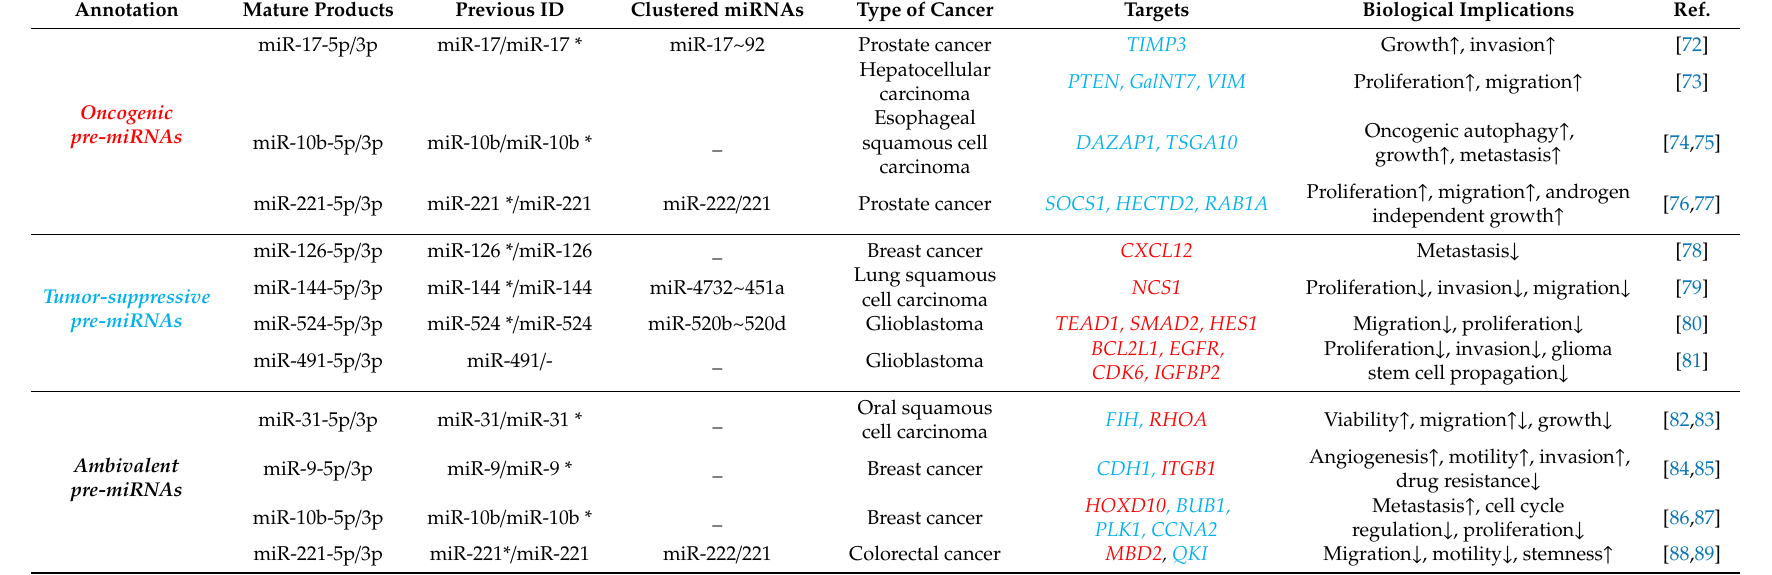
The genes in red / blue indicate the implications in the pro / antioncogenic processes; Abbreviations: TIMP metallopeptidase inhibitor 3 ( TIMP3 ); phosphatase and tensin homolog ( PTEN ); GalNAc transferase 7 ( GalNT7 ); vimentin ( VIM ); DAZ associated protein 1 ( DAZAP1 ); targeting testis specific 10 ( TSGA10 ); suppressers of cytokine signaling 1 ( SOCS1 ); HECT domain